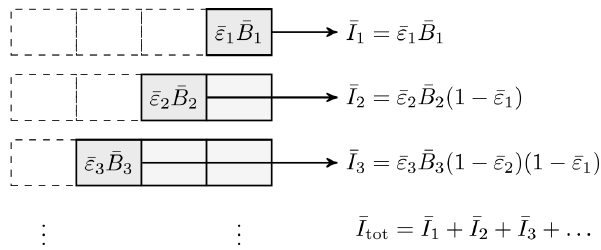
Figure 1. Integration of radiance along a ray path. Contributions ε i B i to the total radiance I tot originate in every segment i of the ray path through the atmosphere. The radiance contributions are partly absorbed due to the transmittance τ 1 ,i − 1 = ( 1 − ε 1 ) × ( 1 − ε 2 ) × ... × ( 1 − ε i − 1 ) along the path. The observer is located on the right side in this